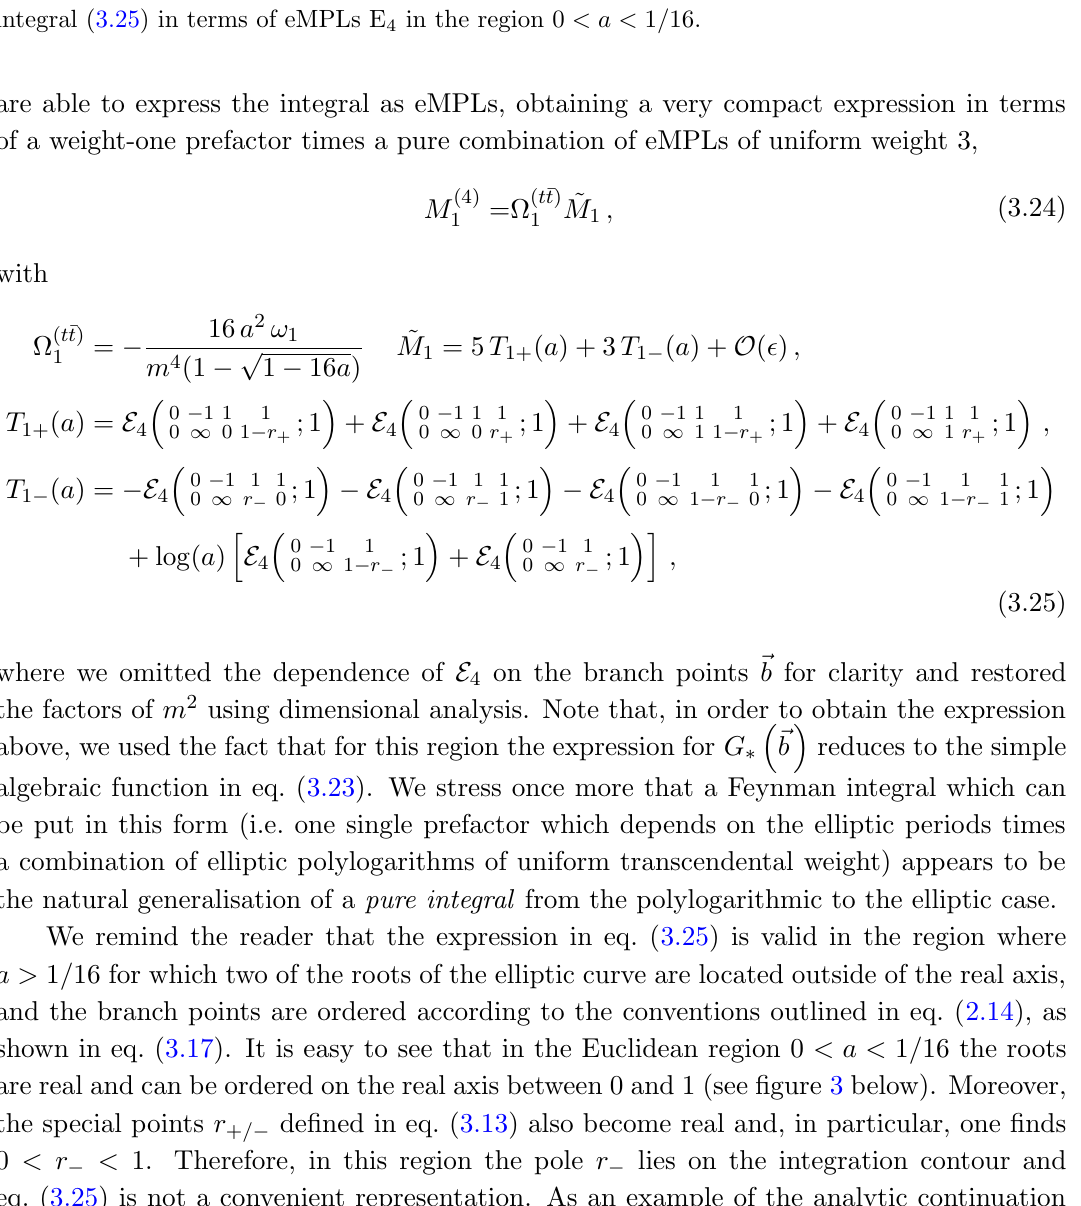
Figure 3 . Location of the ranch points of the (cid:12)nal expression for the top-production triangle integral (3.25) in terms of eMPLs E 4 in the region 0 < a < 1 =